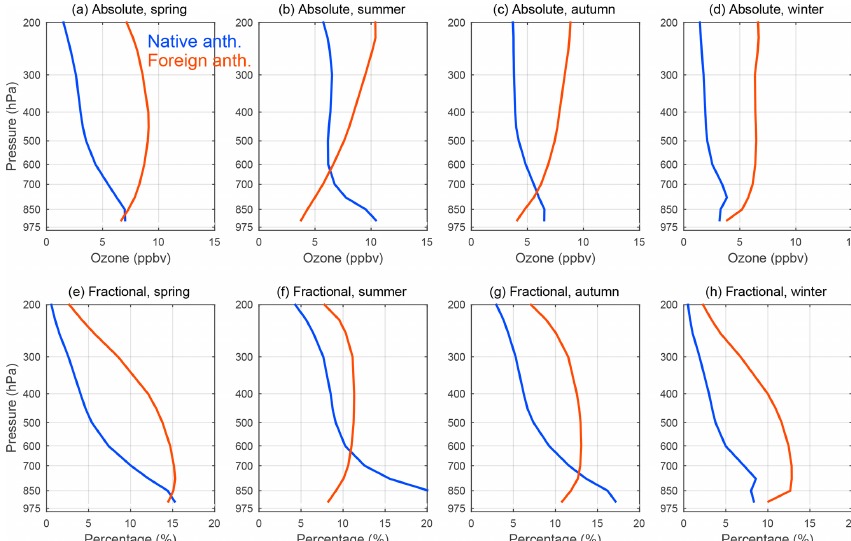
Figure 5. ( a – d ) Vertical variation in native anthropogenic ozone (in blue) and foreign anthropogenic ozone (in red) (in ppbv) averaged over East Asia by season in 2005. ( e – h ) The same as ( a – d ) but for the fractional contribution (in %) of each component to ozone in the East Asian troposphere at each altitude. Note the difference in the scale of the x axis between Figs. 4 and 5. Table 2. The contributions of foreign ozone (in ppbv) from different regions to surface ozone in East Asia in 2005. The fractional contribu- tions are indicated in brackets, taking surface ozone in East Asia as 100%. The results are from the tagged ozone simulations (Experiment 11 in Table 1). ∗